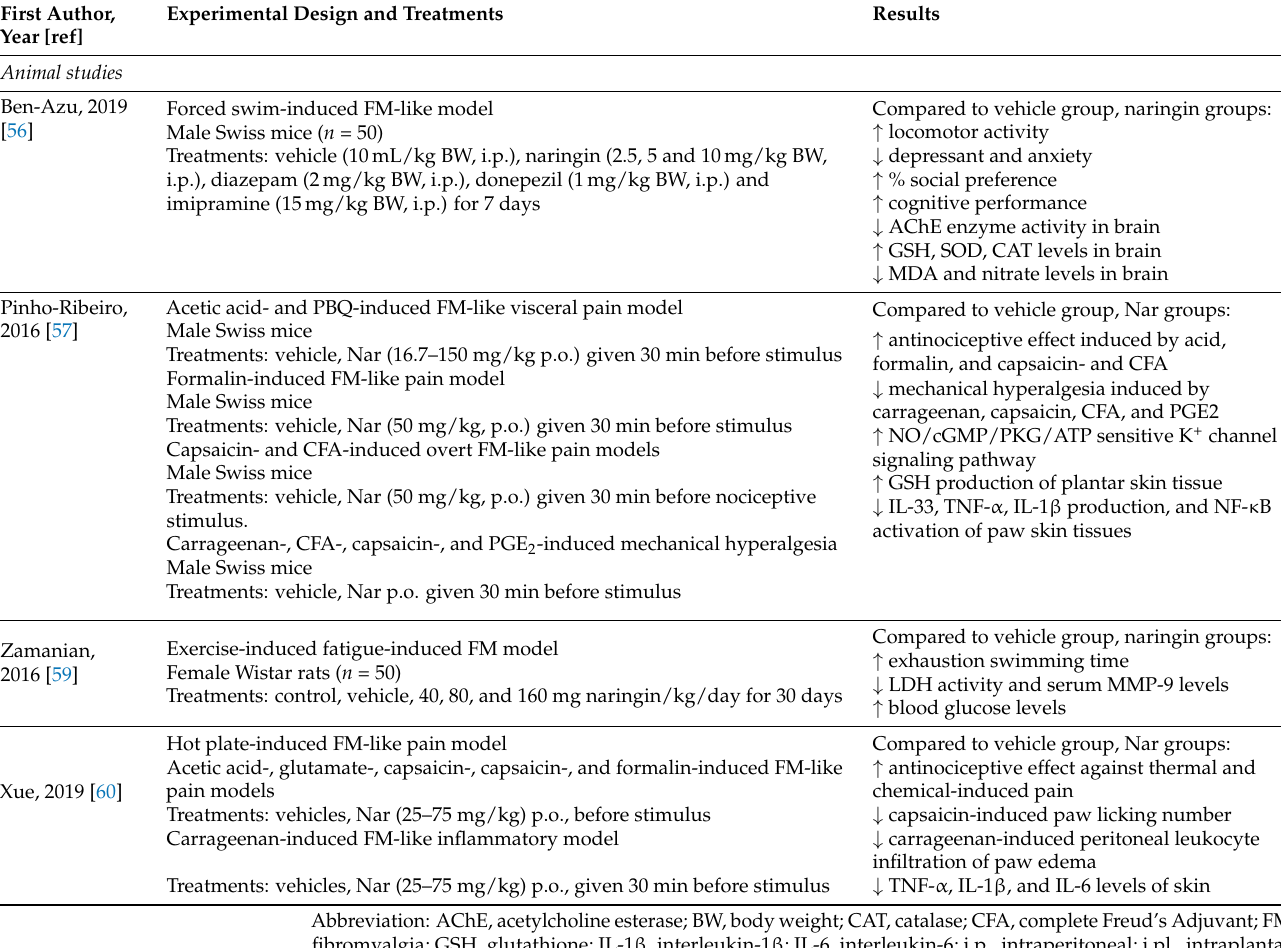
Table 6. Effects of naringin on fibromyalgia-like